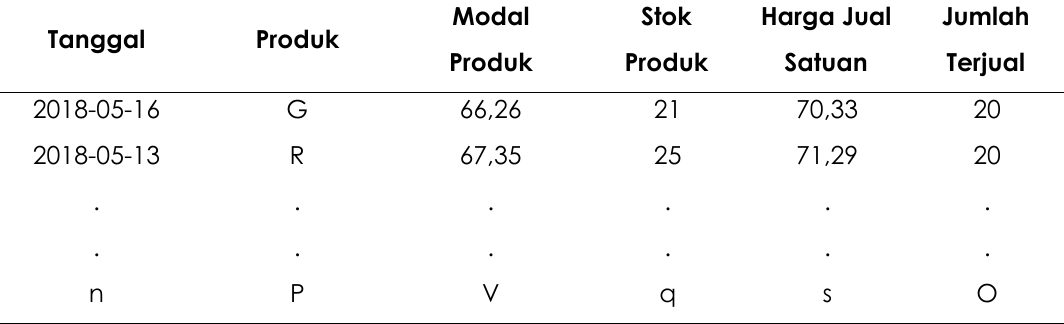
Tabel 2. Struktur Data untuk Sales